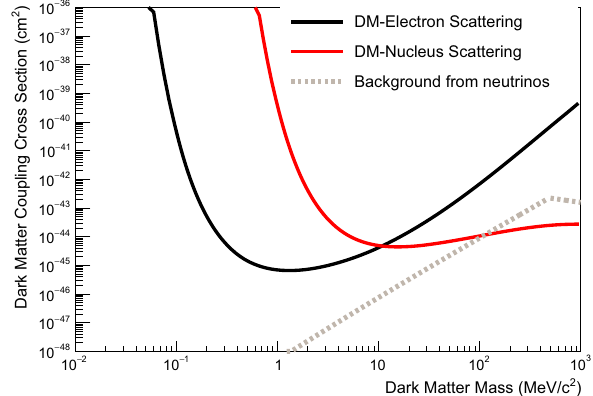
Fig. 15 Shown is the projected experimental sensitivity for a year. The background events are assumed to be only constrained by neutrino induced background events